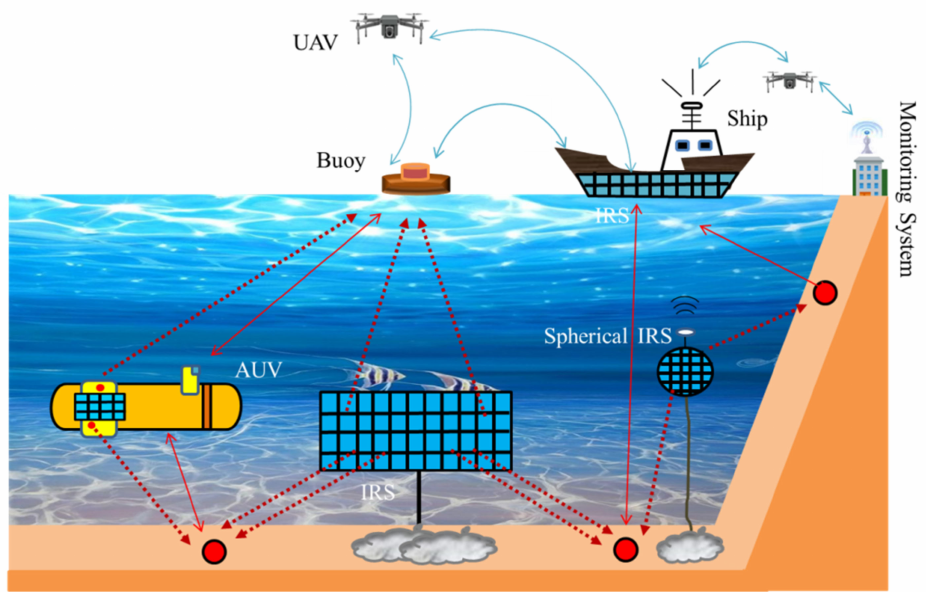
Figure 15. IoUT assisted by IRS-assisted UAV, motivated by